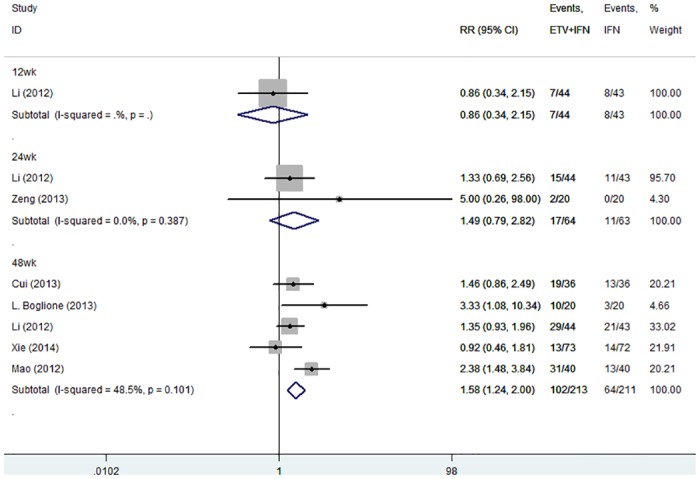
Forest Plot for HBeAg Seroconversion when IFN was used as the Control Group.